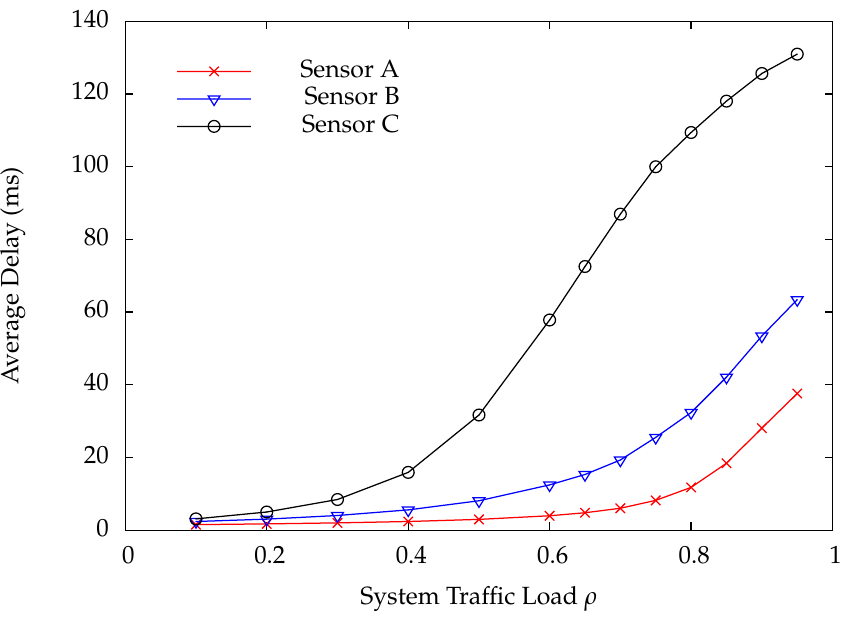
Figure 11. Average delay versus system traffic load ρ .